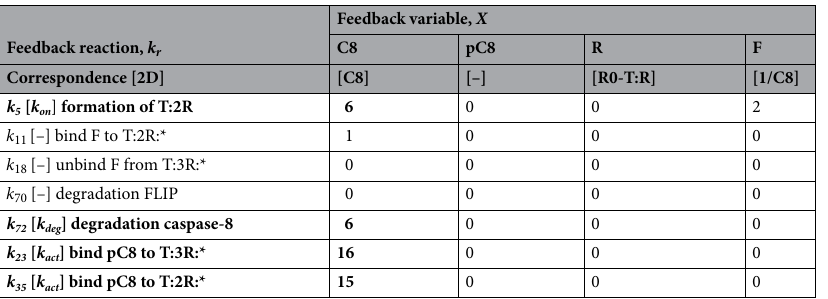
Table 1. Cell profiles with high heterogeneity capacity, for selected feedback reactions and variables in ARRM. The equivalent reactions and variables in the theoretical 2D model are shown between brackets. The reaction parameters in bold correspond to the configurations for which the 2D model predicts universal